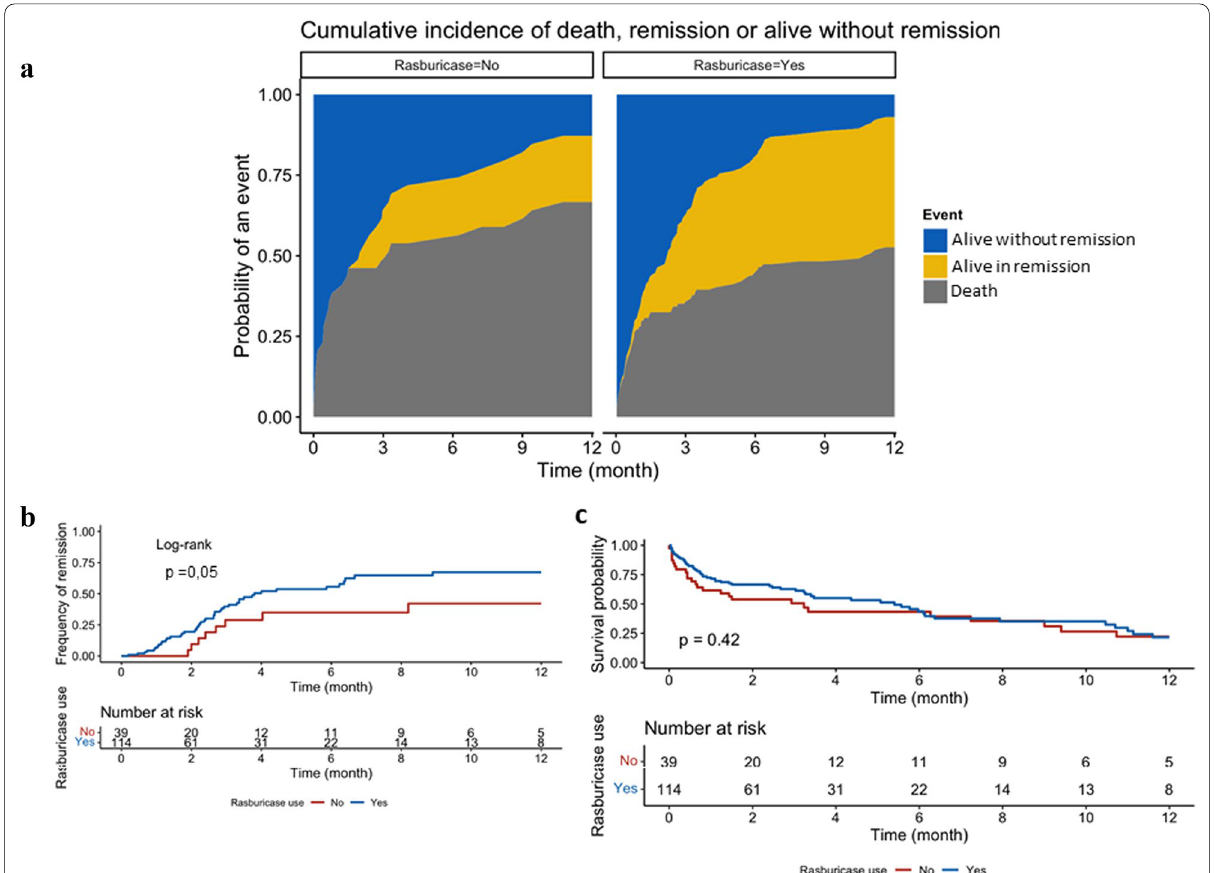
Fig. 3 Outcome according to use of rasburicase before adjustment. a Cumulative incidence of remission according to rasburicase use and taking into account competing risks. b Cumulative incidence of remission according to rasburicase use. c Kaplan–Meier survival estimates according to rasburicase